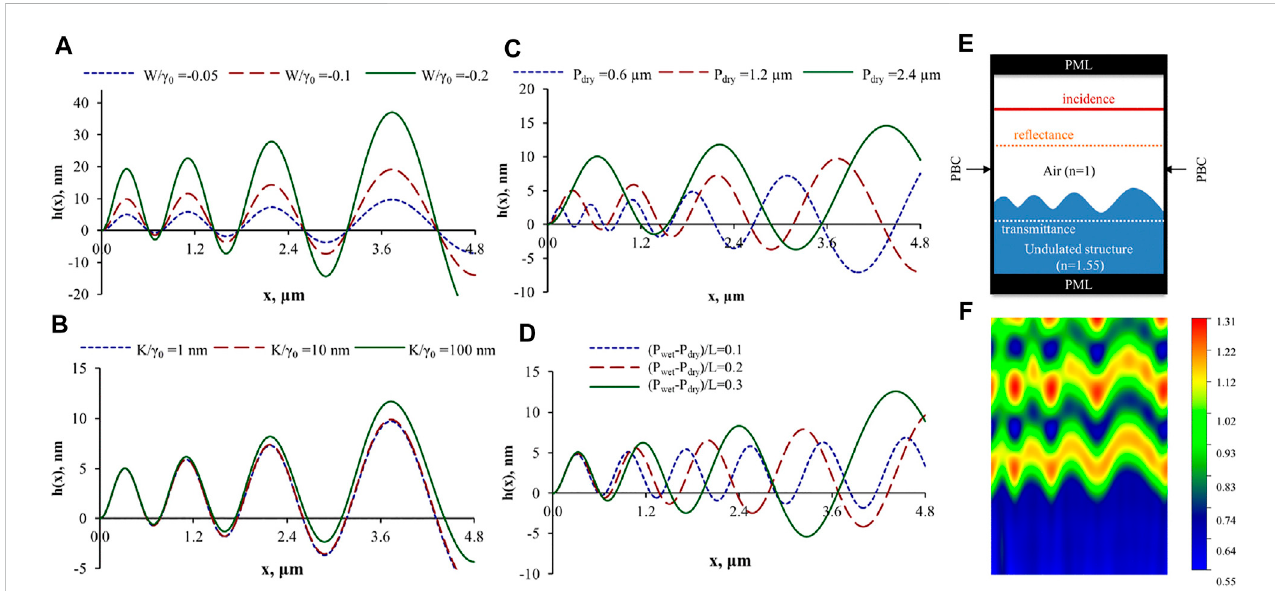
FIGURE 5 (A – D) Surface pro fi les h ( x ) with increasing wrinkling amplitudes and wave-lengths, driven by changes in the orientation spatial scales due to changes in spatial hydration levels; increasing the pitch P 0 by water absorption increase the wrinkling scales. Basic parameters are de fi ned by K / γ 0 =1 nm, P dry =1.2 μ m ( P wet − P dry )/ L =0.2 and W / γ 0 = − 0.05 ( W =2 μ 2 ). (A) Basic parameters are used except for W / γ 0 . (B) Basic parameters are used except for K / γ 0 . (C) Basic parameters are used except for P dry . (D) Basic parameters are used except for ( P wet − P dry )/ L . (E) 2D schematic of air-CCLC (cellulosic cholesteric liquid crystal) interface with varying pitch. (F) Scattered electric fi eld of 480 nm normal incident light for (E) with periodic boundary condition on the left and right wall. Reprinted from (Rofouie et al., 2015a), with permission of AIP